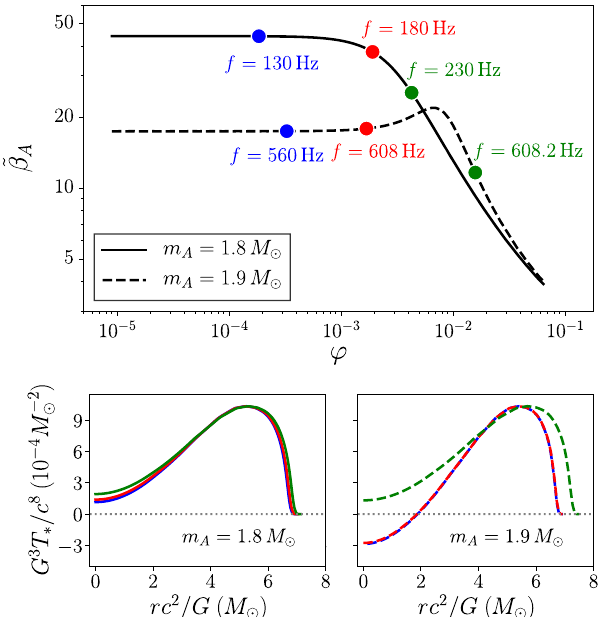
~ β 11. (Top panel) Evolution of for NSs with (dashed line) A and without (solid line) ultrarelativistic cores as a function of the background scalar field. The blue, red, and green annotations indicate the scalar field at each star at frequencies before, during, and after dynamical scalarization in an equal-mass binary system, respectively. (Bottom panels) Profile of the trace of the stress- energy tensor within each NS at each of the annotated points in the top